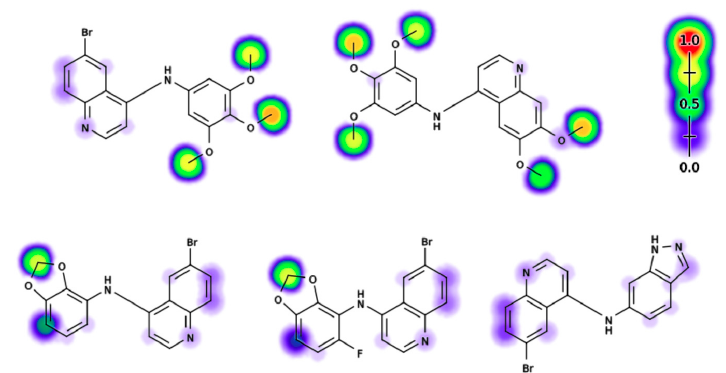
Figure 13. Summary image highlighting the predicted metabolic profiles of 1 , 8 , 9 , 14 , and 35 in XenoSite’s P450 Metabolism P450 1.0 algorithm.